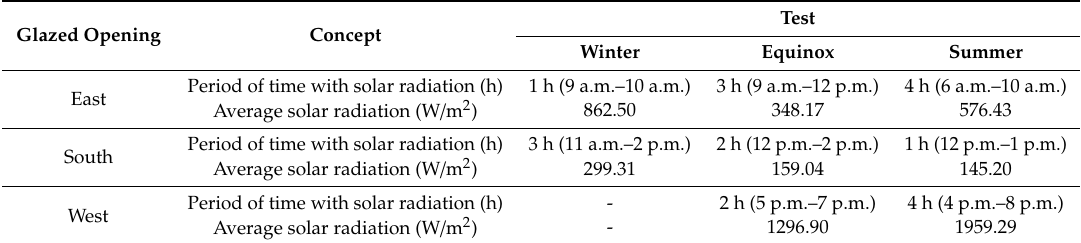
Table 5. Average solar radiation (W / m 2 ) and period of time (h) that receives solar radiation each glazed opening.